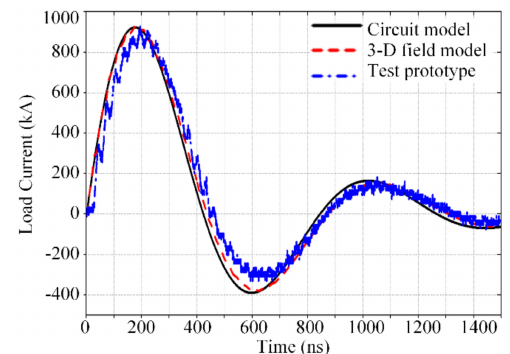
Figure 18. Simulated and measured load current waveforms of the single-stage FLTD.